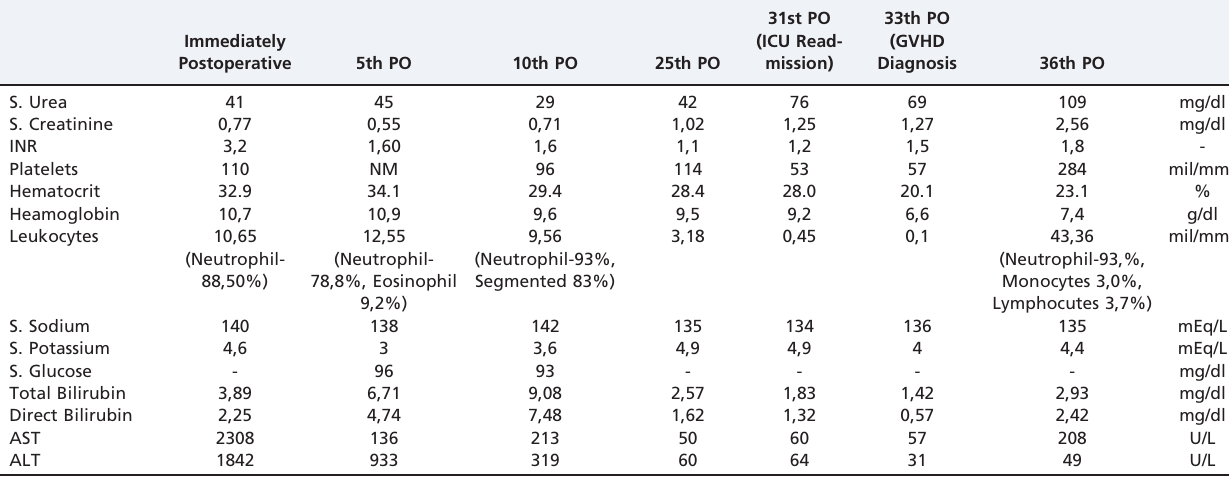
Table 2 - Postoperative laboratorial